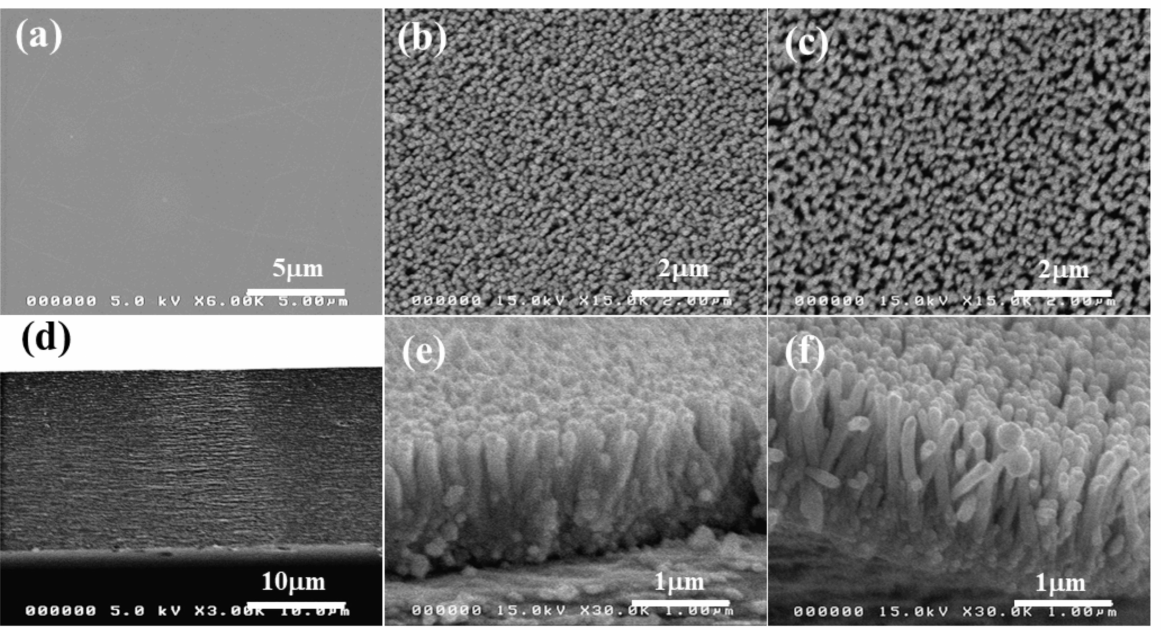
Figure 5. Surface ( a – c ) and cross-sectional ( d – f ) FESEM images: ( a , d ) the pristine CNF film, ( b , e ) 25 mM ZCN, ( c , f ) 50 mM